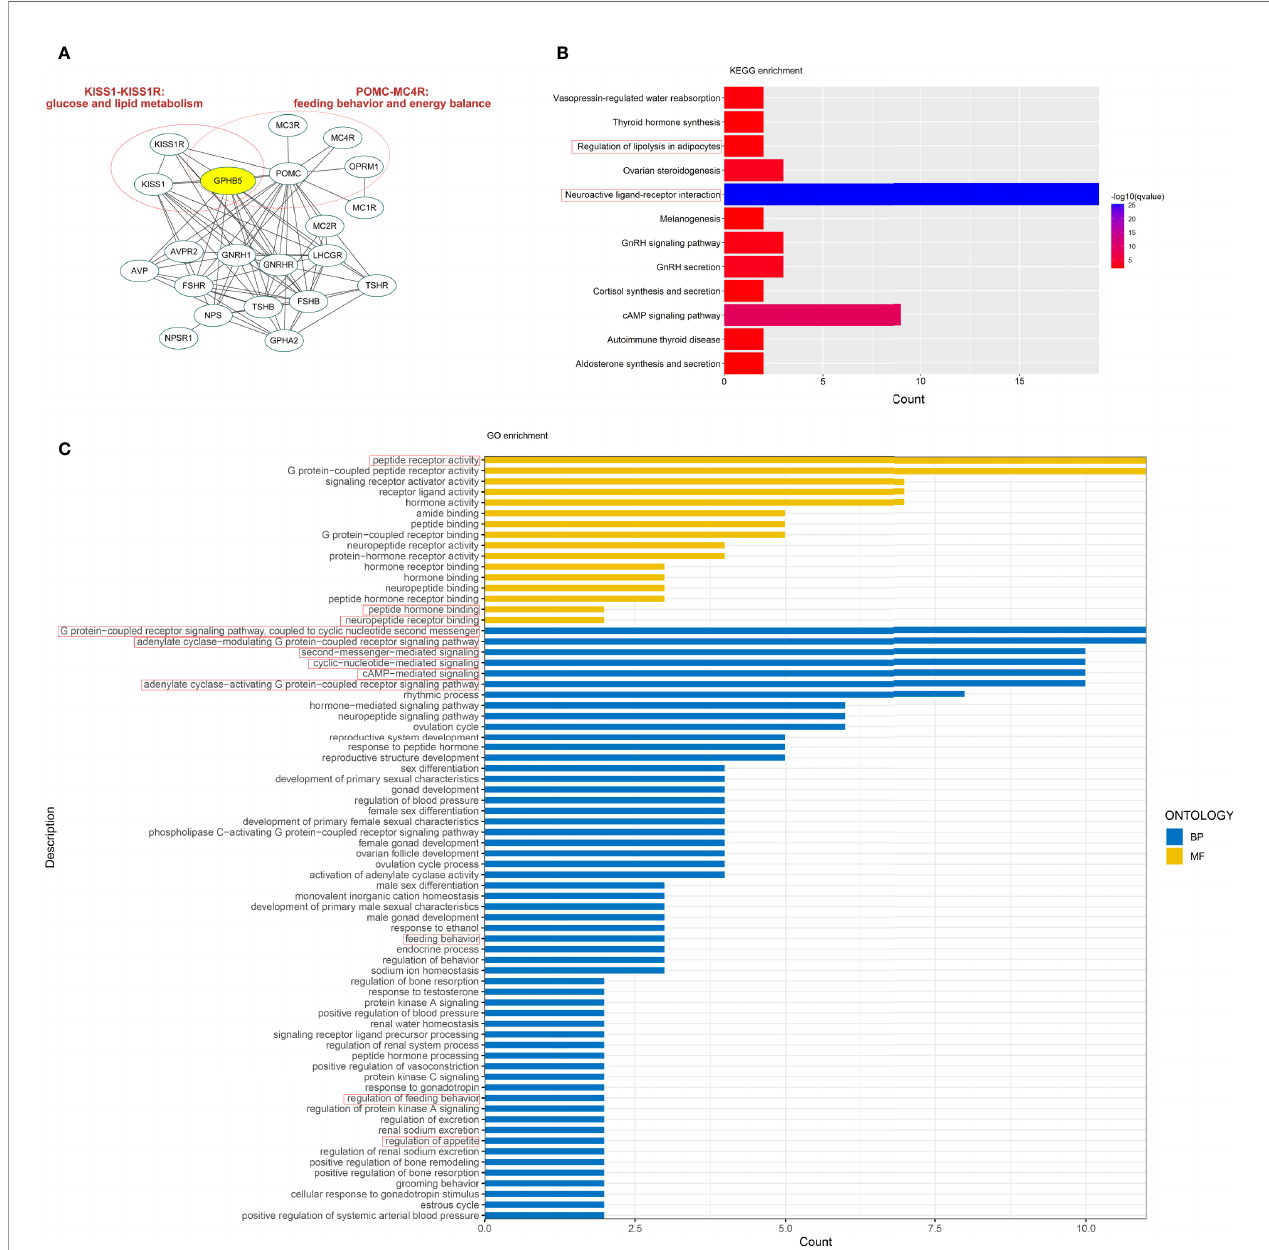
FIGURE 2 | Bioinformatics analysis related to GPHB5. (A) PPI network. (B) KEGG enrichment. (C) GO